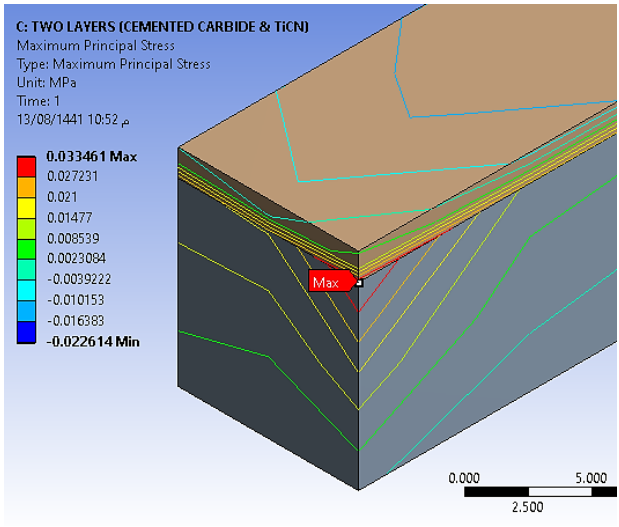
Fig. 20. Maximum principal stress normal force on the TiCN surface without thermal